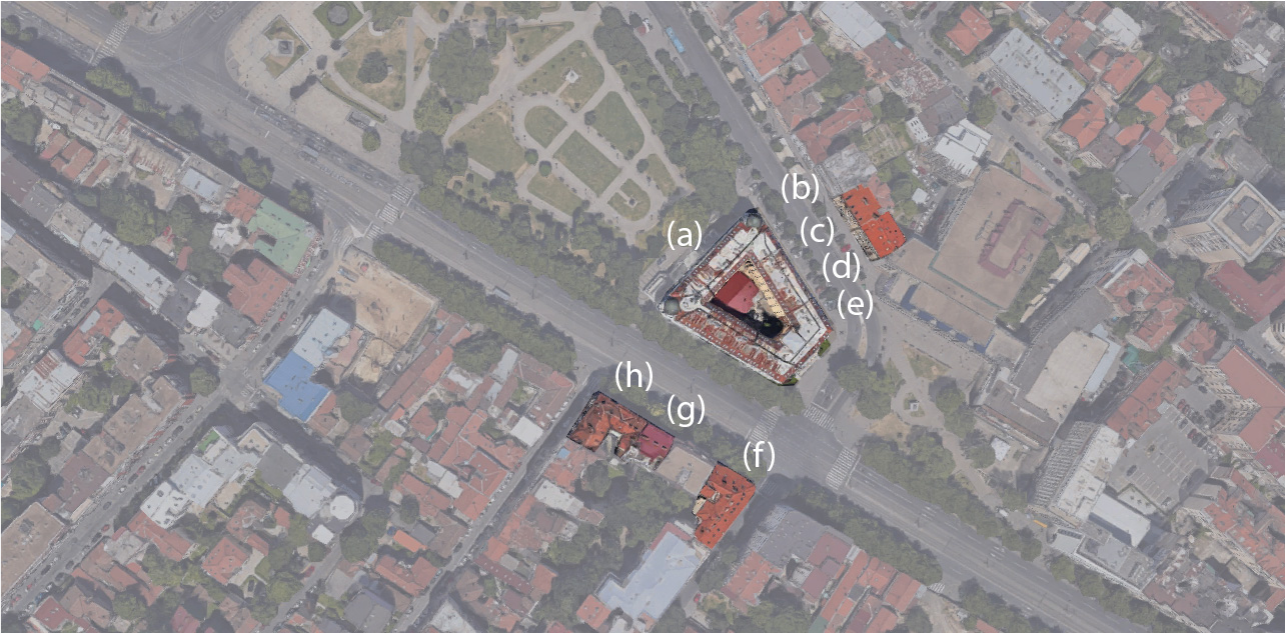
Figure 11. The buildings assessed for the Belgrade study; © Google. Similar to other case studies, expeditious assessment was initially conducted on the observation of structural elements, and archival material was used to reconstruct the con- struction history. Structural and architectural plans were also found for all the buildings. No surveys were carried out using advanced techniques. Building (a) is currently used as the University canteen and dormitory (public build- ing). It was built in 1926 and has a load-bearing structure composed of brickwork. The floors consist of RC cast-in-situ ribbed slabs. The building has a large inner courtyard and is developed as a trapezoid on the four perimeter sides. Building (b) is used for shops on the ground floor and as a residential building on the other levels. It has a highly irregular plan and is characterised by load-bearing brick masonry walls. The investigations carried out did not reveal any recent structural interventions. The other buildings have many common features: they were made of load-bearing masonry, have at least four floors above ground, and were built between 1930 and 1960. The main differences are related to